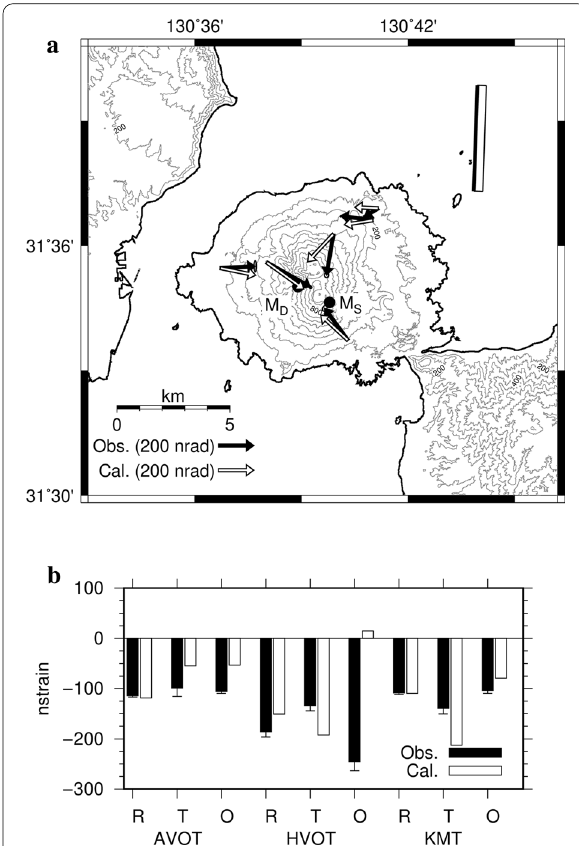
Fig. 7 Same as Fig. 4, but assuming the dual Minami-dake sources M S and M D and an additional dislocation source model (rectangle). The thick black line of the rectangle represents the top of the obtained dislocation source model. The depths of the sources M S , M D and the top of the dislocation source are 0.1 km bsl, 3.3 km bsl and 0.7 km bsl,